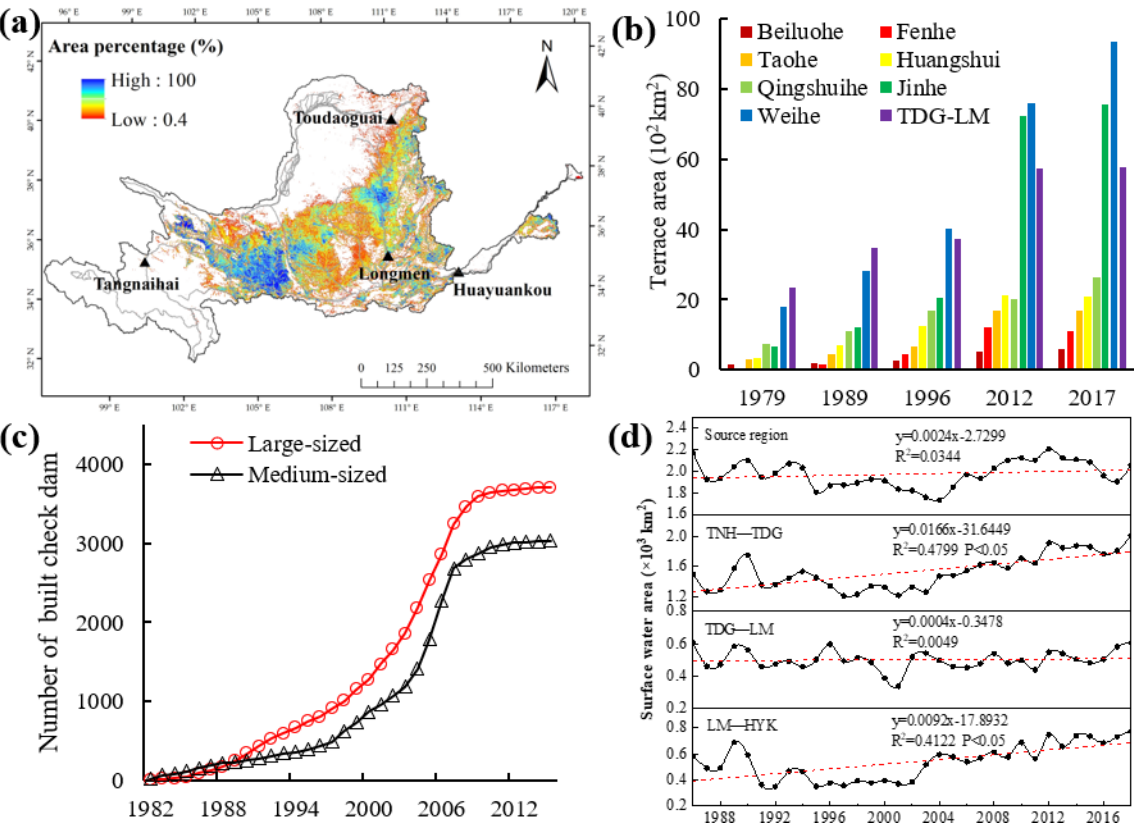
Figure 14. (a) Spatial distribution of area percentage of the terrace at 1km resolution in 2018; (b) terrace areas in different main watersheds from 1979 to 2017; (c) total number of check dams built above Tongguan station from 1982 to 2015; (d) total areas of permanent water bodies in the source region, TNH–TDG, TDG–LM and LM–HYK during